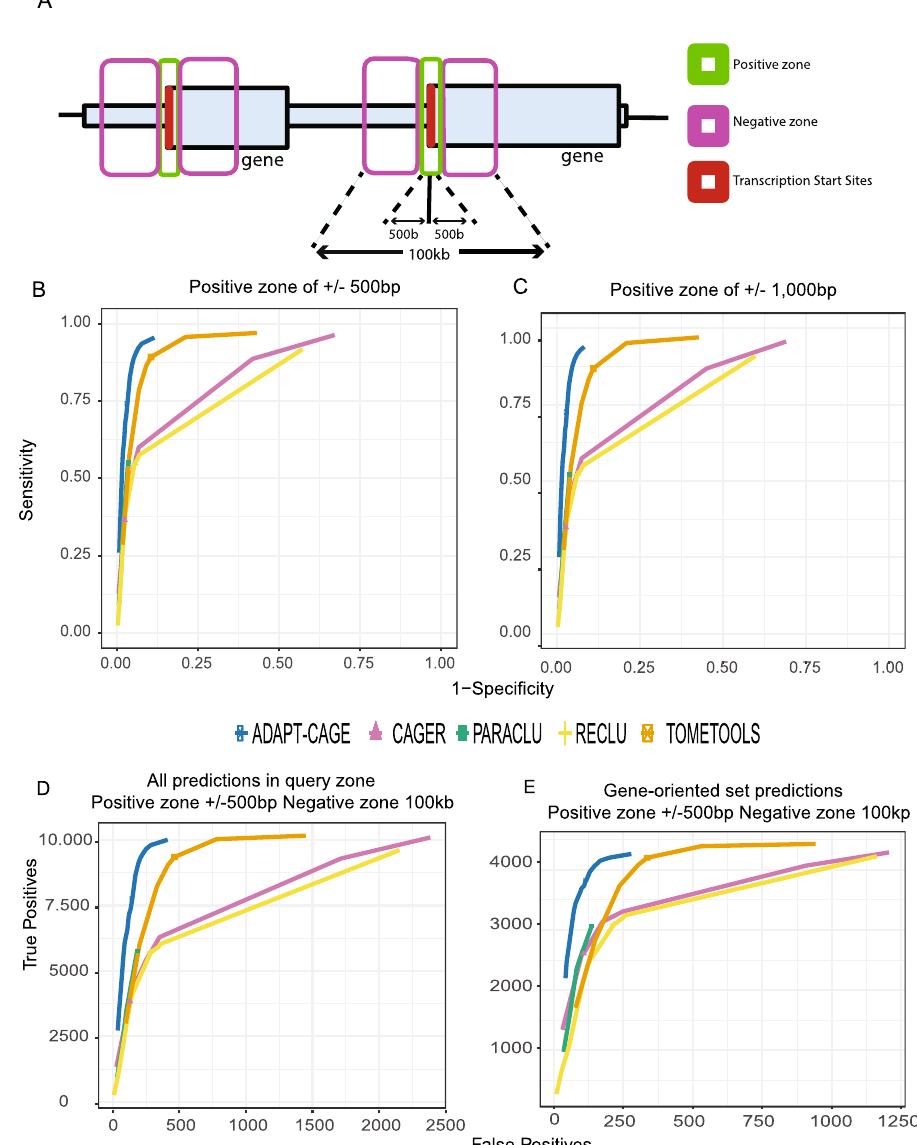
Figure 4. Evaluating algorithms’ performance in H9 cells based on the combination of the human genome annotation and H9 H3K4me3 ChIP-Seq data. For a more systematic comparison of the algorithms’ performance, the human genome annotation was utilized for generating positive and negative zones surrounding annotated protein coding TSSs ( A ). The positive zone was defined as a + / − 500 bp window centered on annotated TSSs. Predictions in this zone were accepted as positives. In the remaining region outside this zone and up to + / − 50 kb away from TSSs (negative zone), all predictions were accepted as negatives, except for predictions that overlapped with H3K4me3 ChIP-Seq peaks that were considered positives. ROC curves based on two different positive zone sizes, + / − 500 bp ( B ) and + / − 1 kb ( C ). The curves were generated by applying multiple ADAPT-CAGE and TOMETOOLS score cutoffs and a range of different parameters for the application of remaining algorithms (from loose to stricter outcomes). The complete range of utilized parameters are shown in Supplementary Table 4. Number of true positives plotted against false positives based on the + / − 500 bp positive zone ( D ), and based on a gene-oriented strategy ( E ). In ( E ), a true positive prediction is a gene that has at least one prediction in the positive zone ( + / − 500 bp around its TSS) and a false positive prediction is a gene with at least one prediction in the negative zone but no predictions in the positive